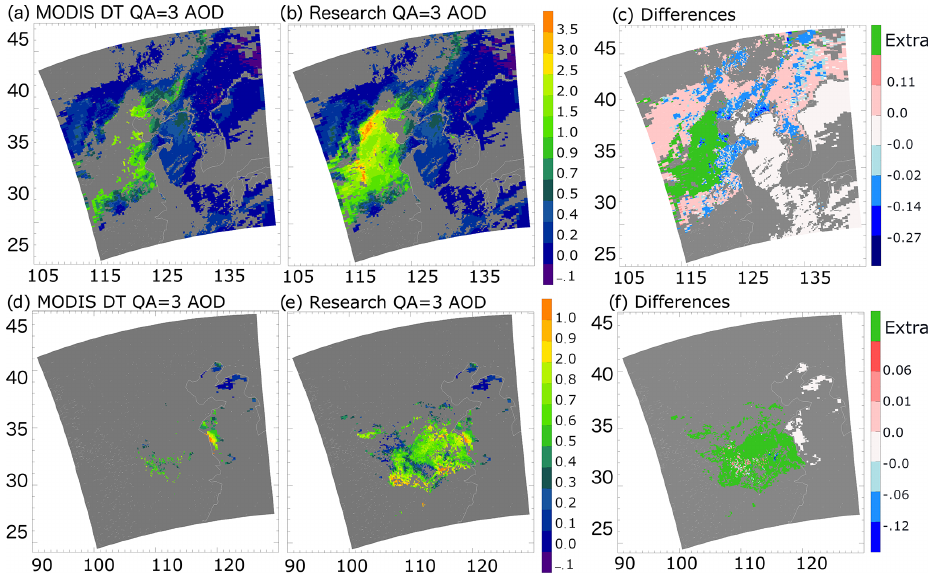
Figure 8. (a–c) AOD images for the case study over eastern China on 9 October 2013: (a) operational DT AOD at 0.55µm with QA = 3, (b) Research AOD at 0.55µm with QA = 3 using altered thresholds on the NDVI test, snow test, and a new regional aerosol model with new aerosol scale height. (c) The differences between the research AOD (b) and the DT AOD (a) . Panels (d) to (f) are for a case study of moderate pollution over eastern China on 13 December 2018. The increased research AOD data coverage is shown in green.